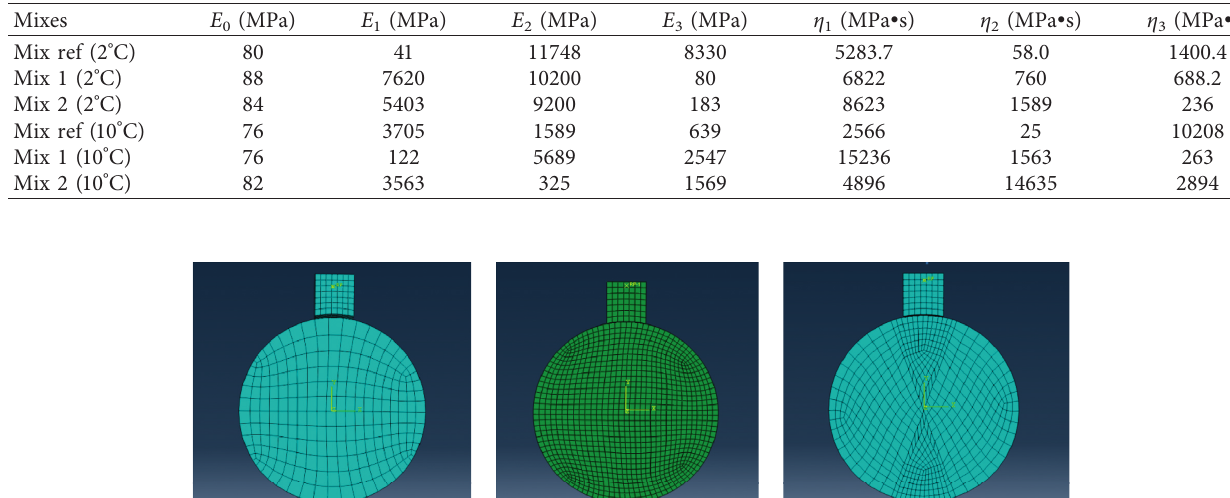
Table 5: Parameters for characterizing the GMM.